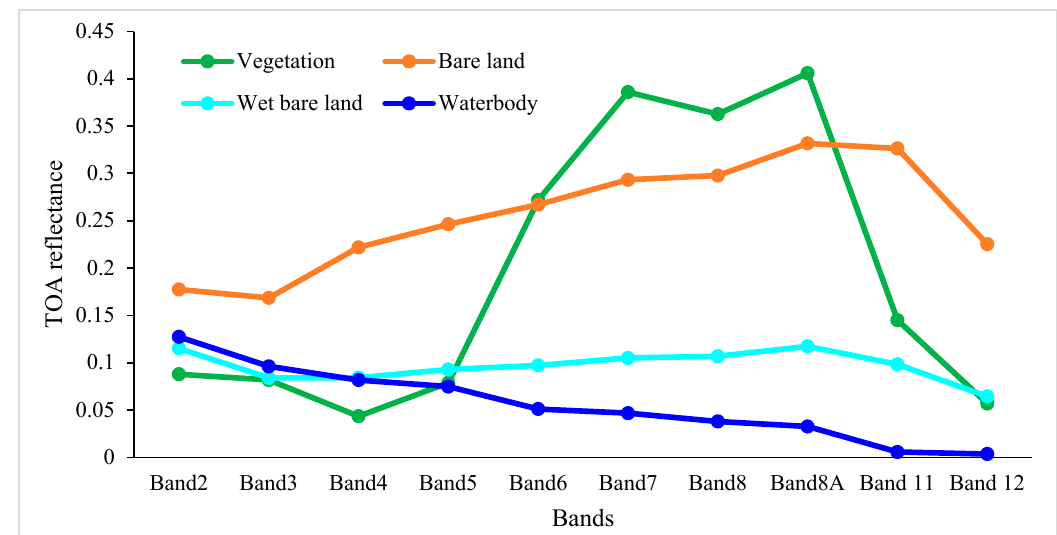
Figure 2. Typical spectral profiles of vegetation, waterbodies, bare land, and wet bare land. The figure was generated using the Sentinel-2 TOA reference average of intra-annual training samples. Band2, Band3, Band4, Band5, Band6, Band7, Band8, Band8A, Band11, and Band12 represent Blue, Green, Red, Red-edge 1, Red-edge 2, Red-edge 3, NIR (broad), NIR (narrow), SWIR1, and SWIR 2 bands of Sentinel-2 data, respectively.